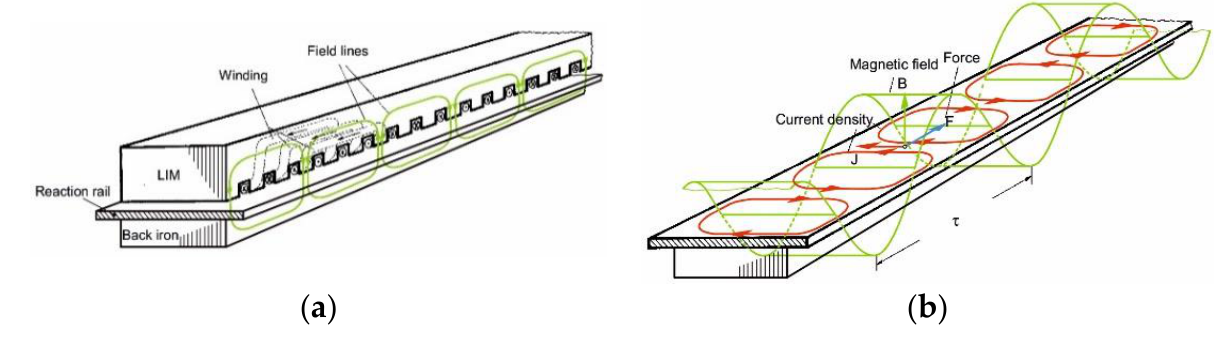
Figure 4. Three-dimensional model of the LIM [29].